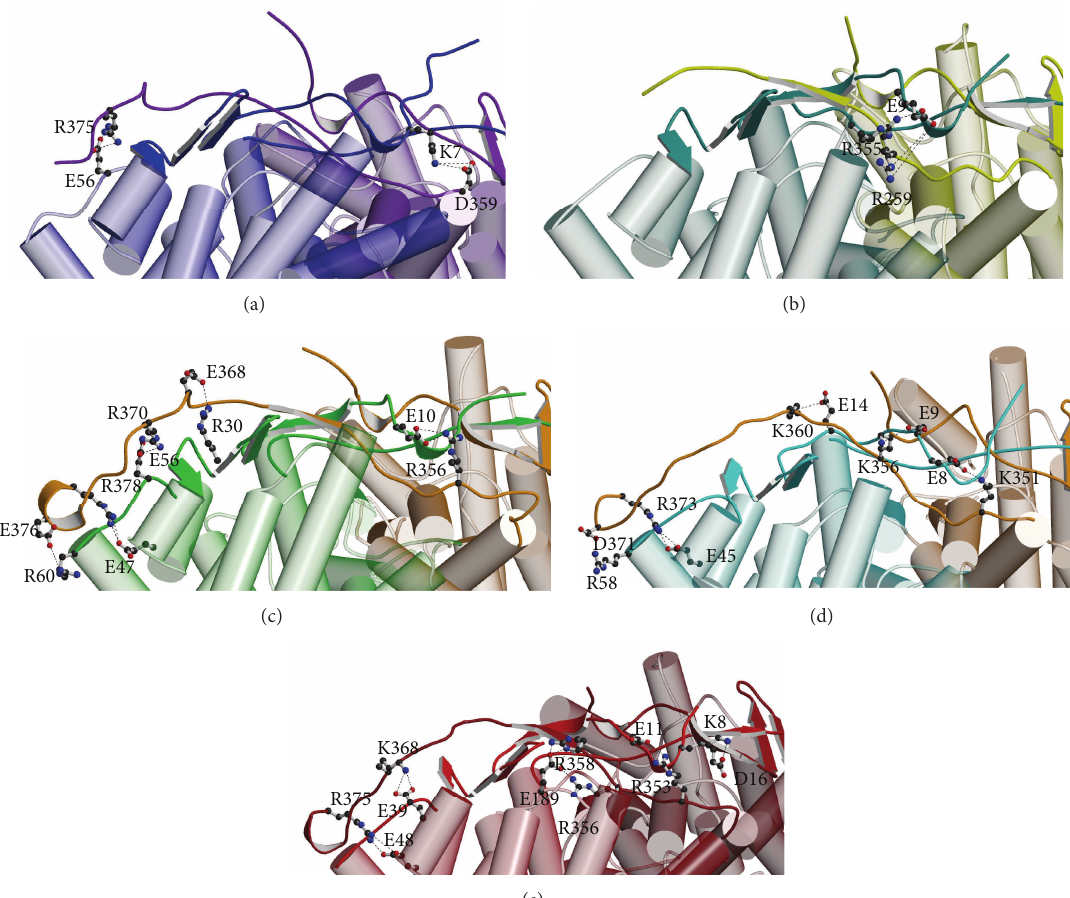
Figure 7: Ion pairs and networks in the terminal domain of PF (a), SS-CS (b), ST1805-CS (c), ST0587-CS (d), and PF-CS (e). Polypeptide chains are shown with a cylinder model. Residues involved in ion pairs are drawn as a ball-and-stick model. Carbon, oxygen, and nitrogen atoms are shown in black, red, and blue, respectively. Hydrogen bonds are indicated as a dotted